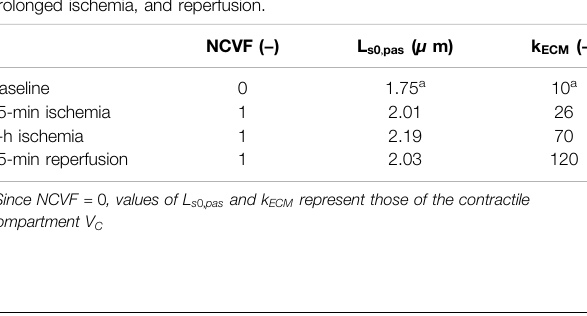
TABLE 4 | Patient characteristics of the selected DEFI-MI subcohort. n 6 (83% Male) Age at baseline